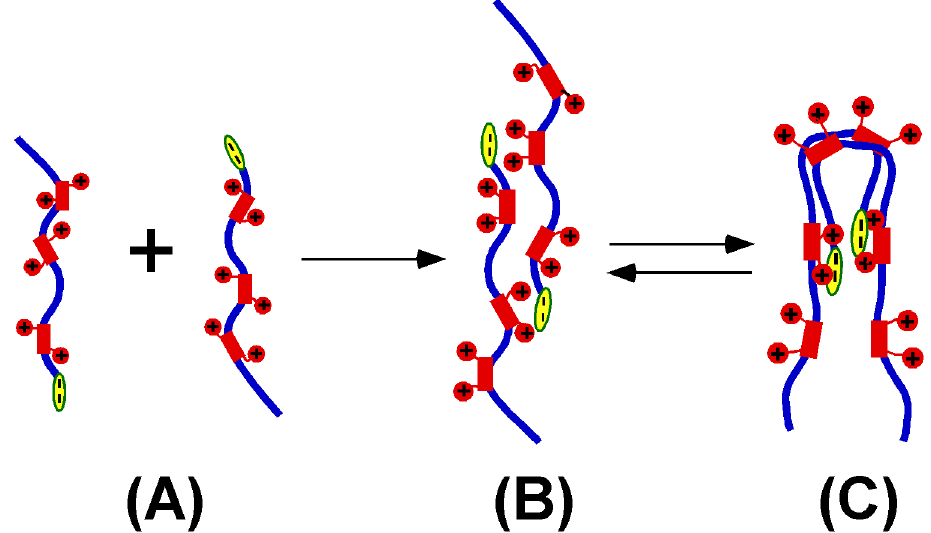
Fig 7. A possible model for the HMGA2 homodimerization. Blue lines represent the protein backbone. Electrostatic interactions between the positively charged “ AT hooks ” (red rectangle with two red circles) and the negatively charged C-terminus (yellow oval) coordinate the dimer formation. (A) represents HMGA2 monomers. (B) and (C) represent different interchangeable conformations of HMGA2 homodimers. (C) is more consistent with our EDC cross-linking and sedimentation velocity results. The HMGA2 homodimers may be an ensemble of different conformers.